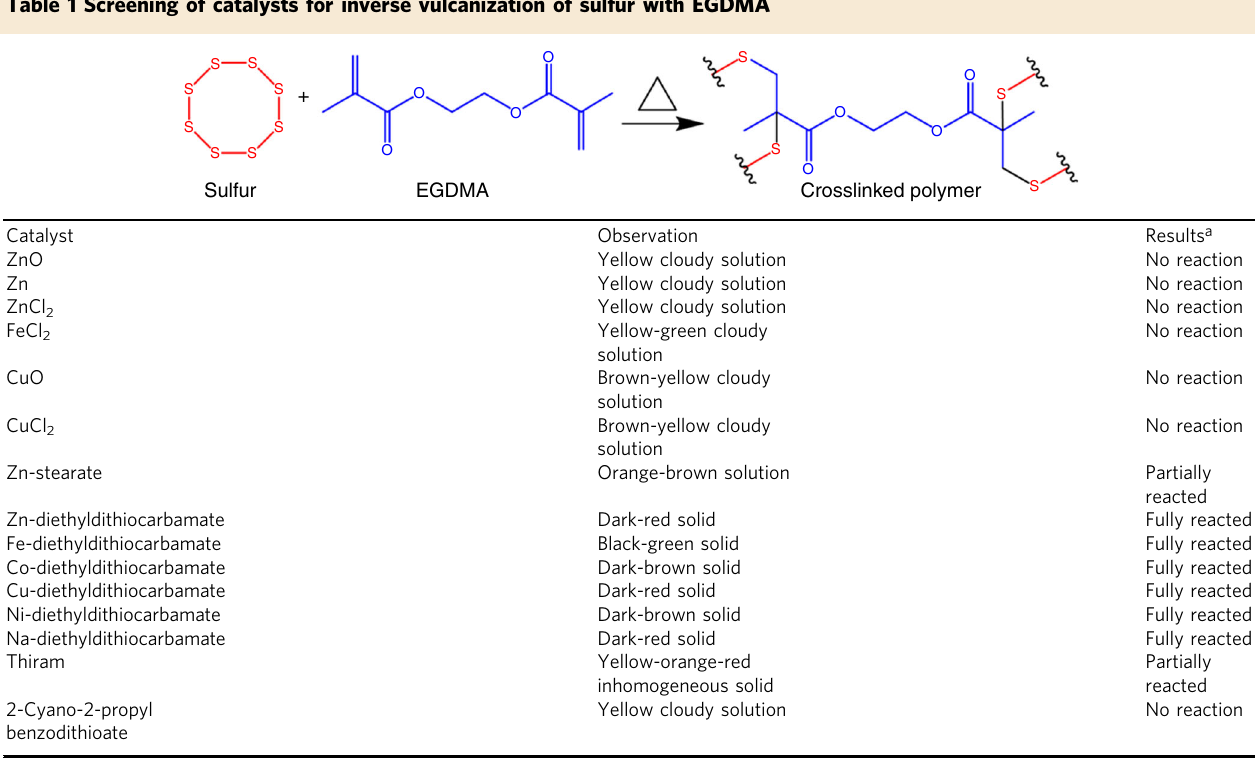
Table 1 Screening of catalysts for inverse vulcanization of sulfur with